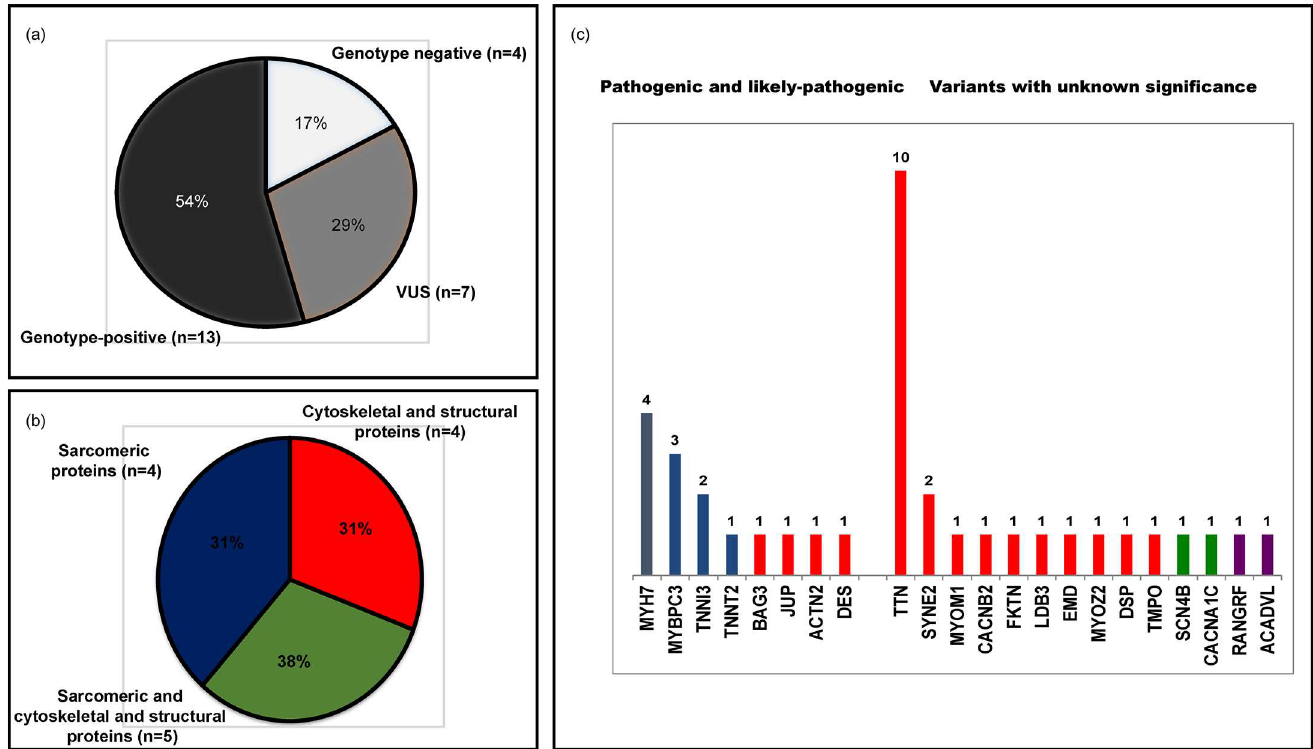
Fig 1. Genetic variants, identified in patients with RCM. (a) Overall yield of genotype-positive (pathogenic and likely pathogenic) variants and variants of unknownsignificance accordingto ACMG classification. (b) Genes where pathogenic, likely pathogenic variants and variants of unknown significance were detected. Blue corresponds to the genes encodingfor sarcomeric proteins, red—to the genes encodingfor cytoskeletal proteins, green—toion channels and purple to the other genes. (c) Combination of pathogenic variants, likely pathogenic variants and variants of unknown significance in patients with